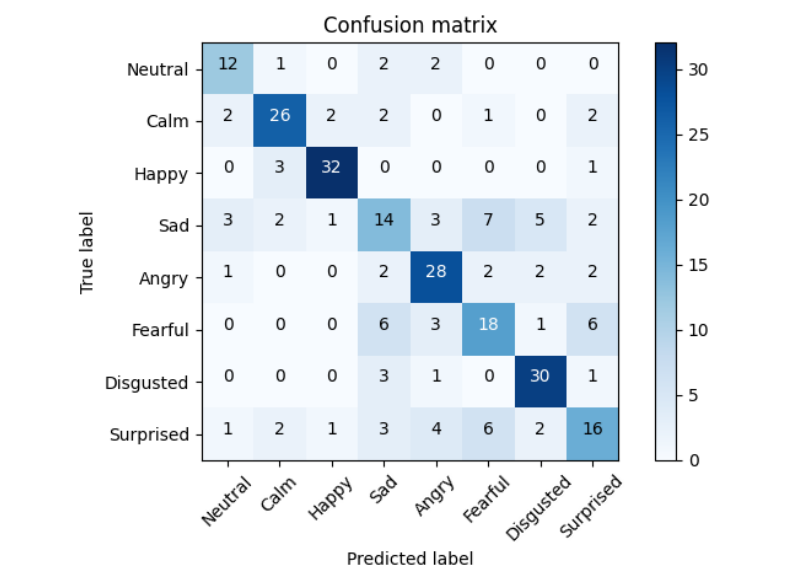
Figure 6. Average confusion matrix of the bi-LSTM with 2 layers of 50 neurons and 2 attention layers trained with the AUs. Accuracy of 62.13%. See Table